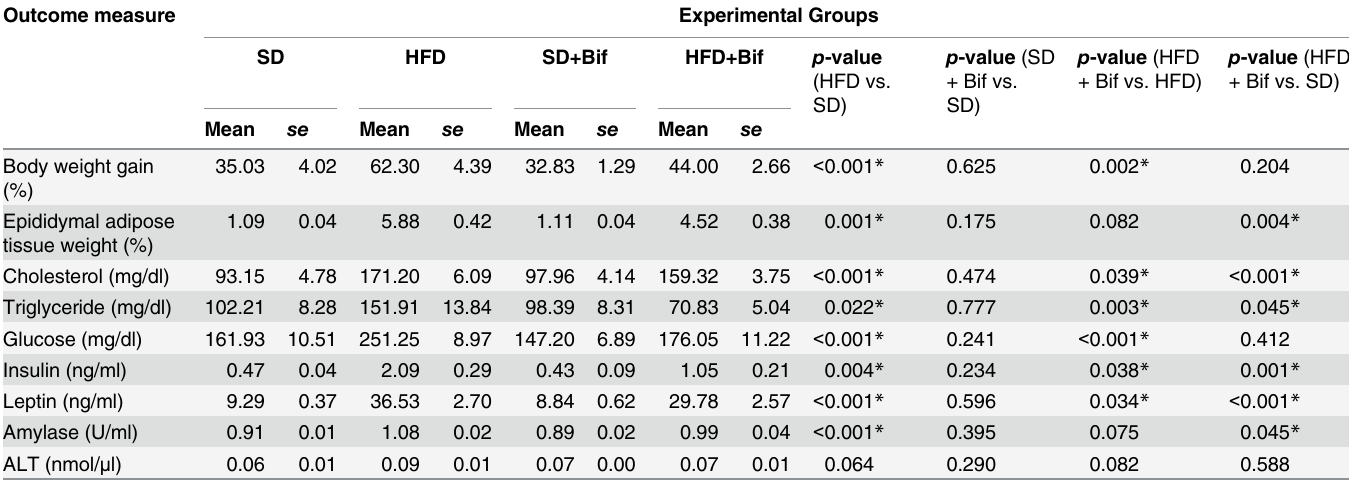
Table 1. Weight gain and serum hormonal and biochemical parameters in different mouse groups after 14 weeks of dietary intervention. Outcome measure Experimental Groups